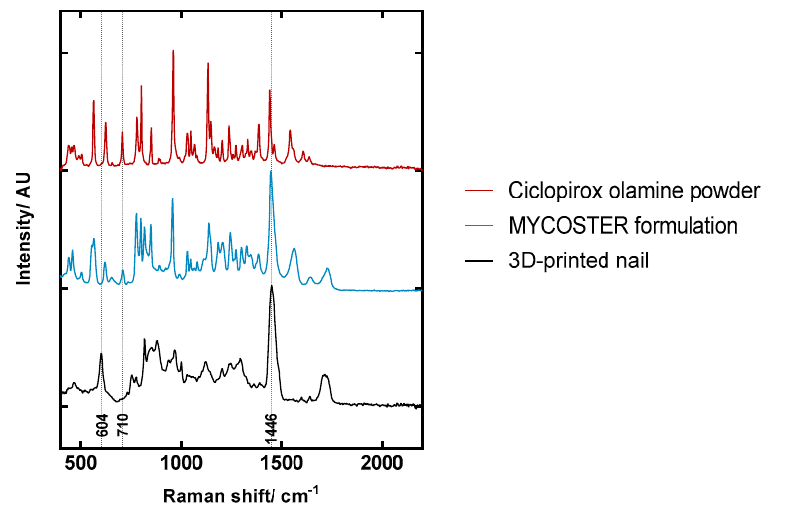
Figure 3. Reference spectra for Ciclopirox olamine, Mycoster ® and 3D printed nail.